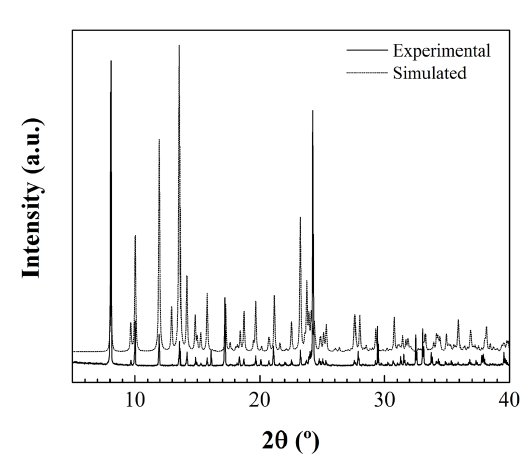
Fig. 2. Experimental ( solid line ) vs . calculated ( dashed line ) X-ray powder diffraction patterns for [UO